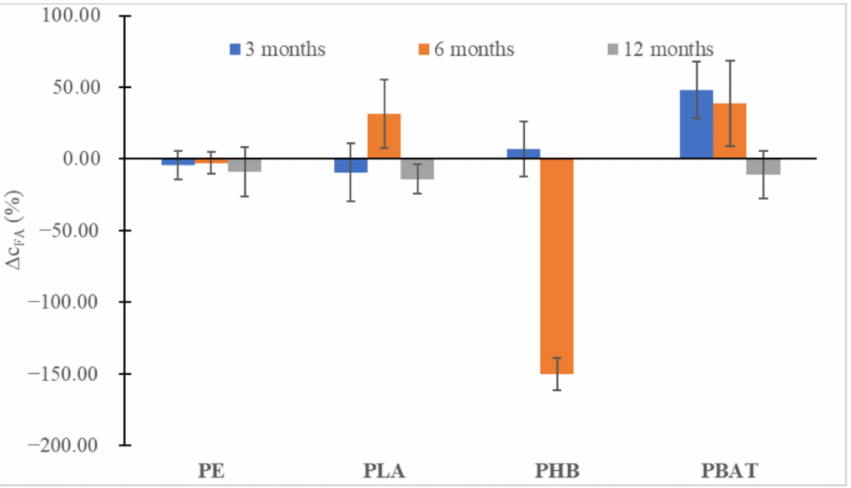
Figure 7. The percentual change in FA concentrations in the soil after 3, 6 and 12 months of incubation relative to FA content in blank